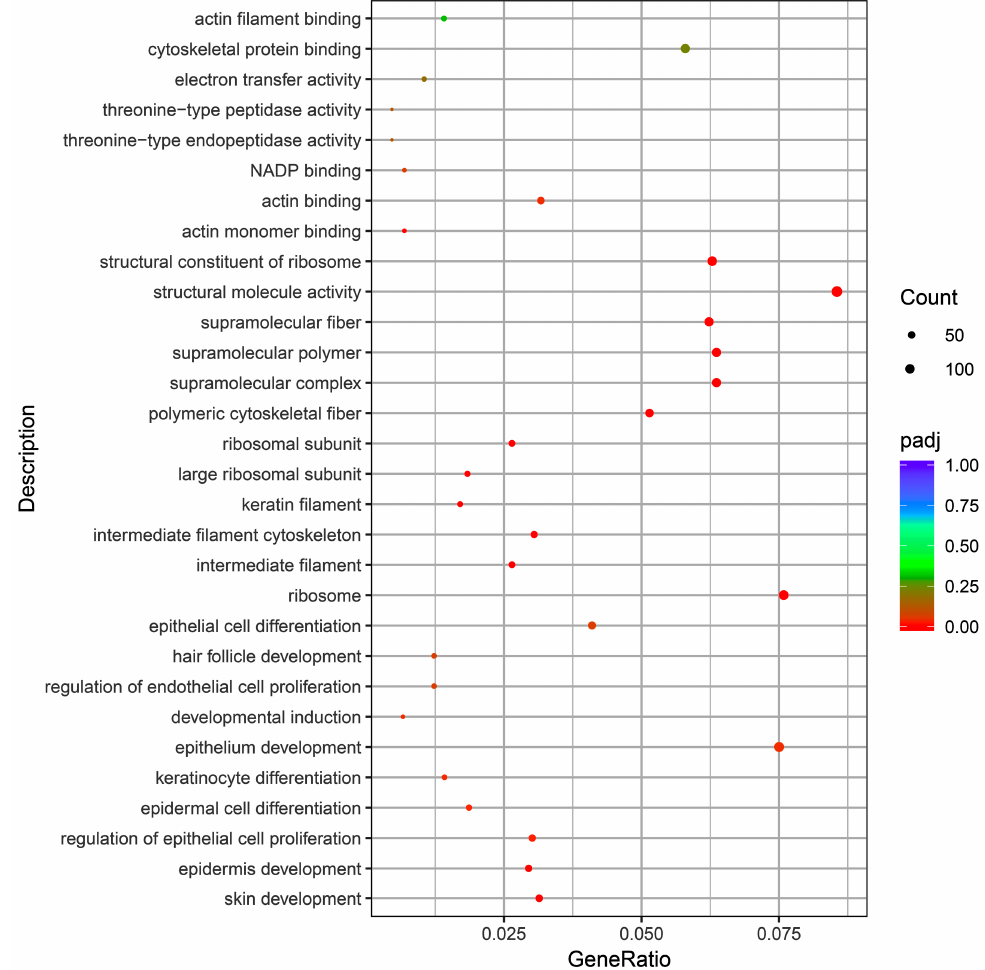
Figure 3. GO analysis of DEGs in hair follicles between coarse and fine wool. p value < 0.05 was considered to indicate a significant difference.